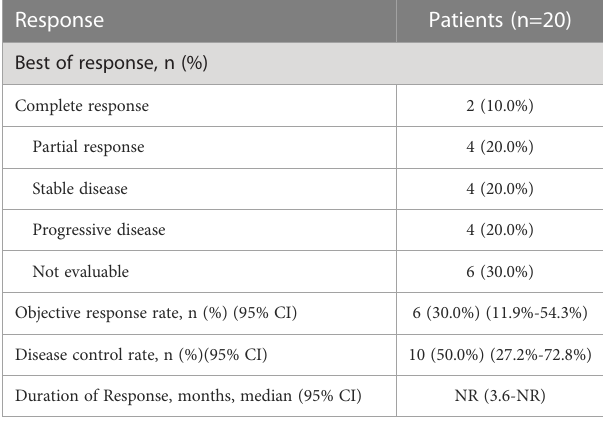
TABLE 2 Tumor response of all